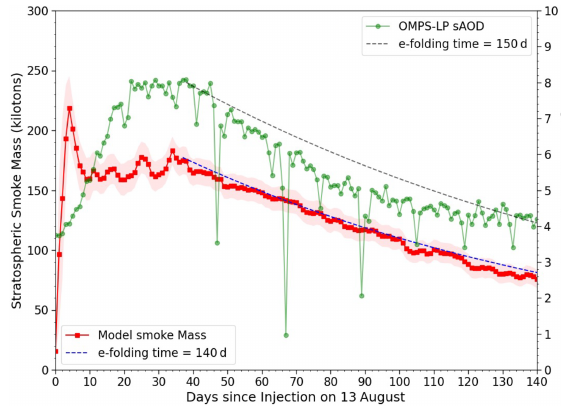
Figure 12. Decay rate of stratospheric smoke mass and optical depth. The primary y axis shows the variation of model-estimated stratospheric smoke aerosol (BC + BrC) mass (red) after the ini- tial injection day, while the secondary y axis shows the variation in terms of OMPS-LP-retrieved stratospheric AOD (green). The shaded area on the model mass curve (red) depicts the uncertainty in stratospheric smoke mass estimation caused by the inclusion or exclusion of the smoke mass residing at the model vertical level that contains the tropopause. The stratospheric aerosol decay rate is calculated starting at 38d after initial injections and depicted using the exponential decay curves and corresponding e -folding times for both model (blue dashed line) and OMPS-LP data (black dashed